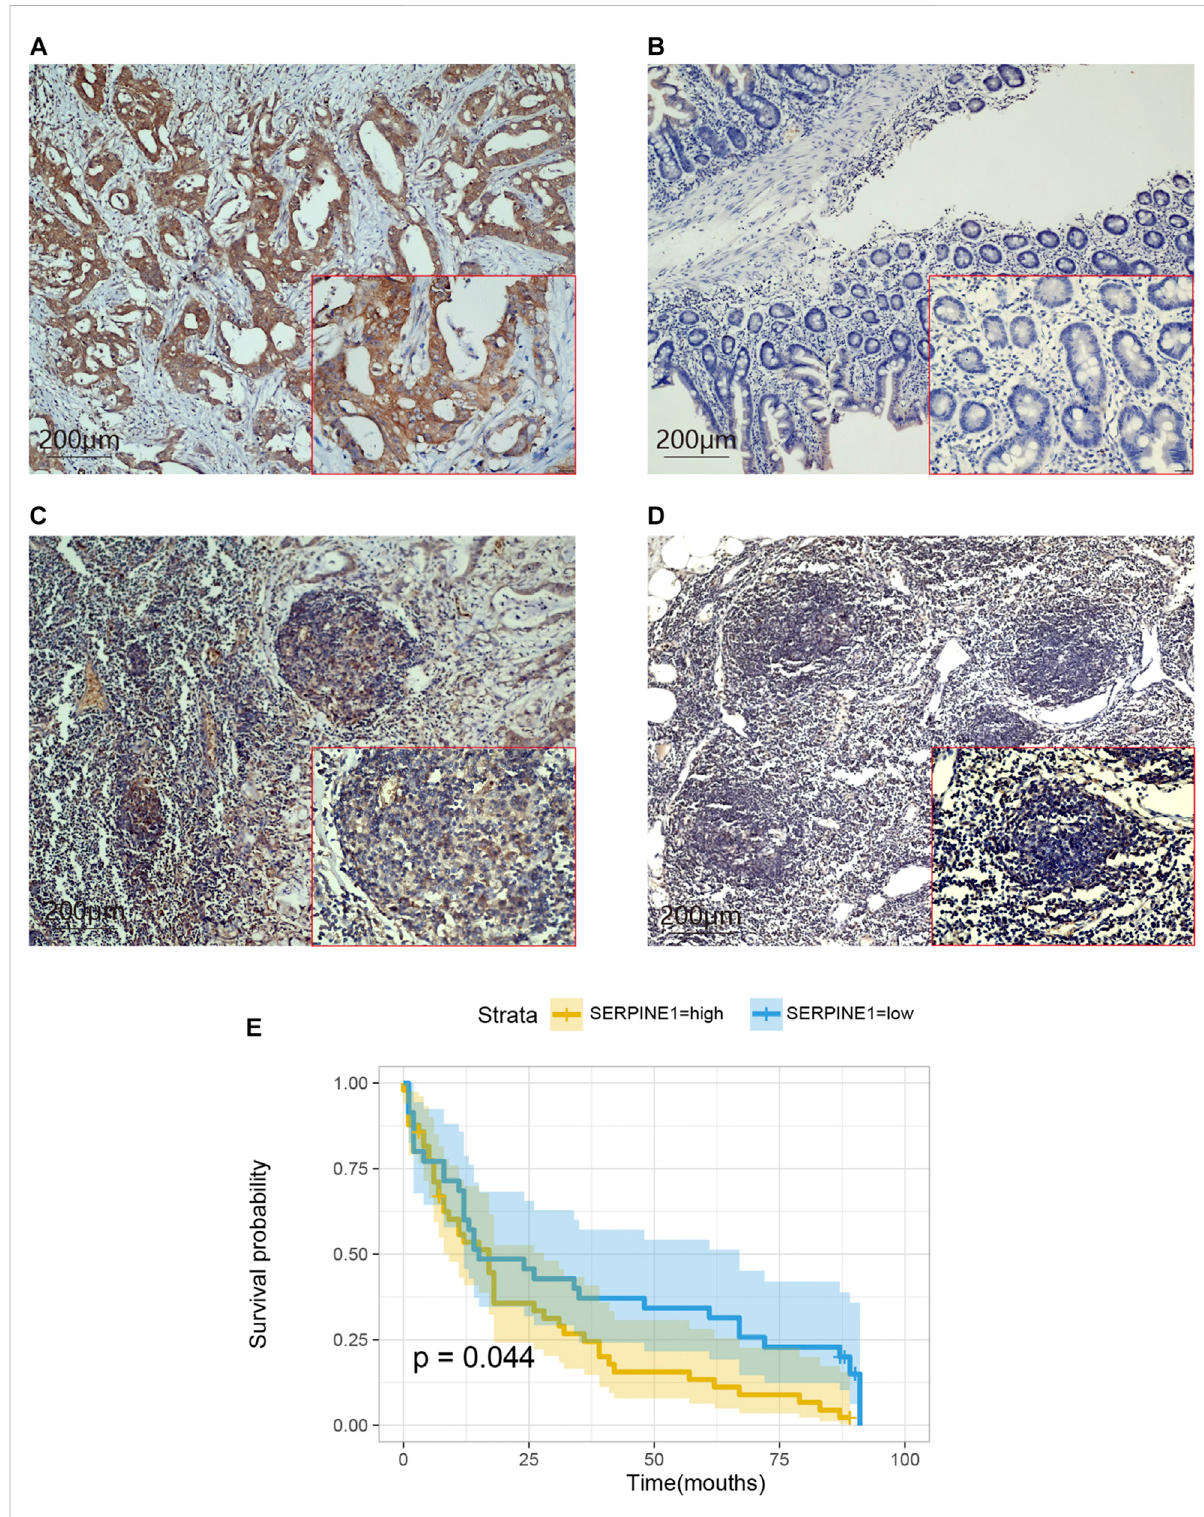
FIGURE 9 ExpressionandprognosticvalueofSERPINE1inGC. (A) PositivestainingofSERPINE1inGCtissues. (B) NegativestainingofSERPINE1inadjacent tissues. (C) Positive staining of SERPINE1 in positive lymph node metastasis tissues. (D) Negative staining of SERPINE1 in negative lymph node metastasis tissues. (E) The survival analysis SERPINE1 low and high expression